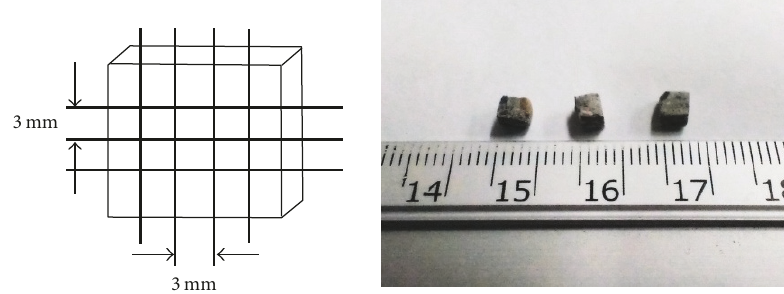
Figure 7: Cubic specimens in 3 × 3 × 3mm. size.